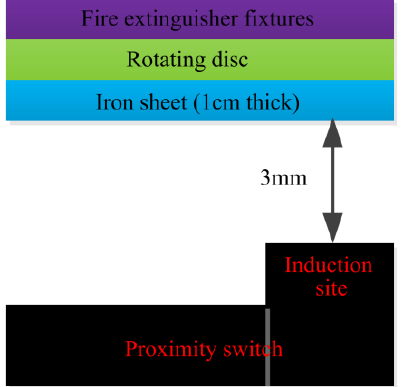
Figure 12. Schematic diagram of the installation position of the proximity switch.